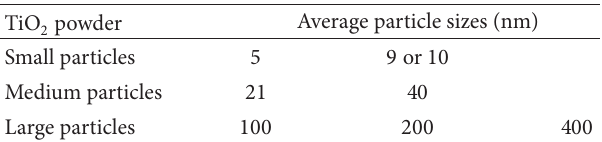
particle sizes used in the experi-